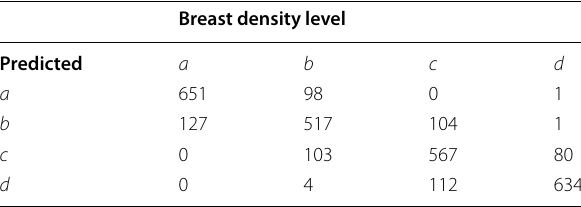
Table 4 Confusion matrices for multinomial logistic regression on the test